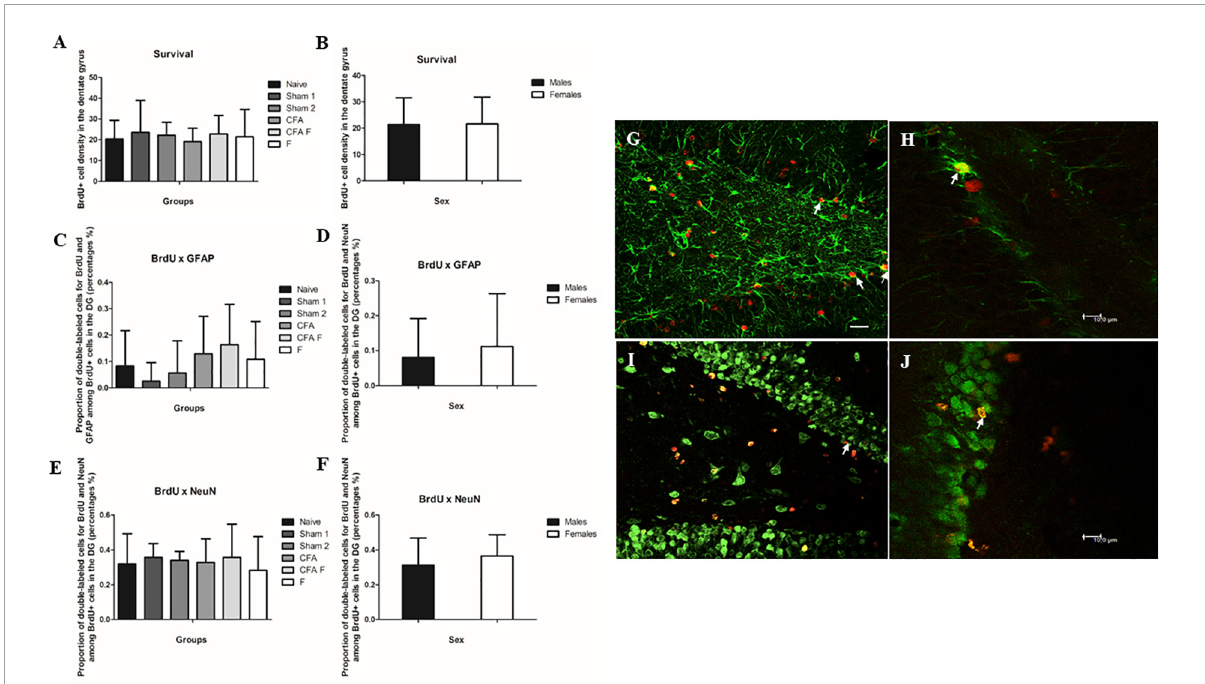
FIGURE4 Cell survival and cell differentiation in the dentate gyrus. (A) No significant differences were found in BrdU-labeled cells in the dentate gyrus among the treatment groups. (B) No significant differences were found in BrdU-labeled cells in the dentate gyrus between the sexes. (C) No significant differences were found for double-labeled cells GFAP + /BrdU + in the dentate gyrus among the treatment groups. (D) No significant differences were found for double-labeled cells GFAP + /BrdU + in the dentate gyrus between the sexes. (E) No significant differences were found for double-labeled cells NeuN + /BrdU + in the dentate gyrus among the treatment groups. (F) No significant differences were found for double-labeled cells NeuN + /BrdU + in the dentate gyrus between the sexes. (G) Fluorescence microscopy, 40 × magnification. The arrows show double-labeled cells by BrdU and GFAP (BrdU red and GFAP green). (H) Confocal image. The arrow shows a double-labeled cell by BrdU and GFAP (BrdU red and GFAP green). (I) Fluorescence microscopy, 40 × magnification. The arrow shows a double-labeled cell by BrdU and NeuN (BrdU red and NeuN green). (J) Confocal image. The arrow shows a double-labeled cell by BrdU and NeuN (BrdU red and NeuN green). Scale bar for panels (G) and (I) 25 µ m.